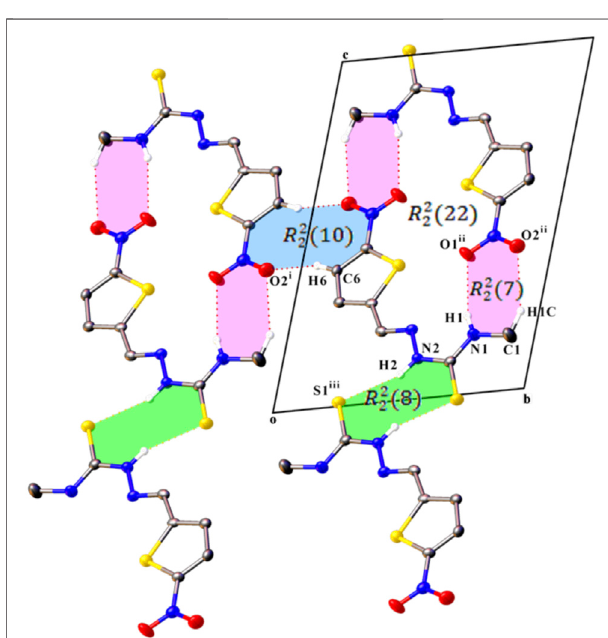
FIGURE 2 | A partial view along the a axis of the crystal packing of compound L1, showing the formation of a cyclic R ring motifs formed by C – H / O, N – H / O, and N – H / S hydrogen bonds. H atoms not involved in hydrogen bonding have beenomittedforclarity.Symmetrycodesareas in Table 3